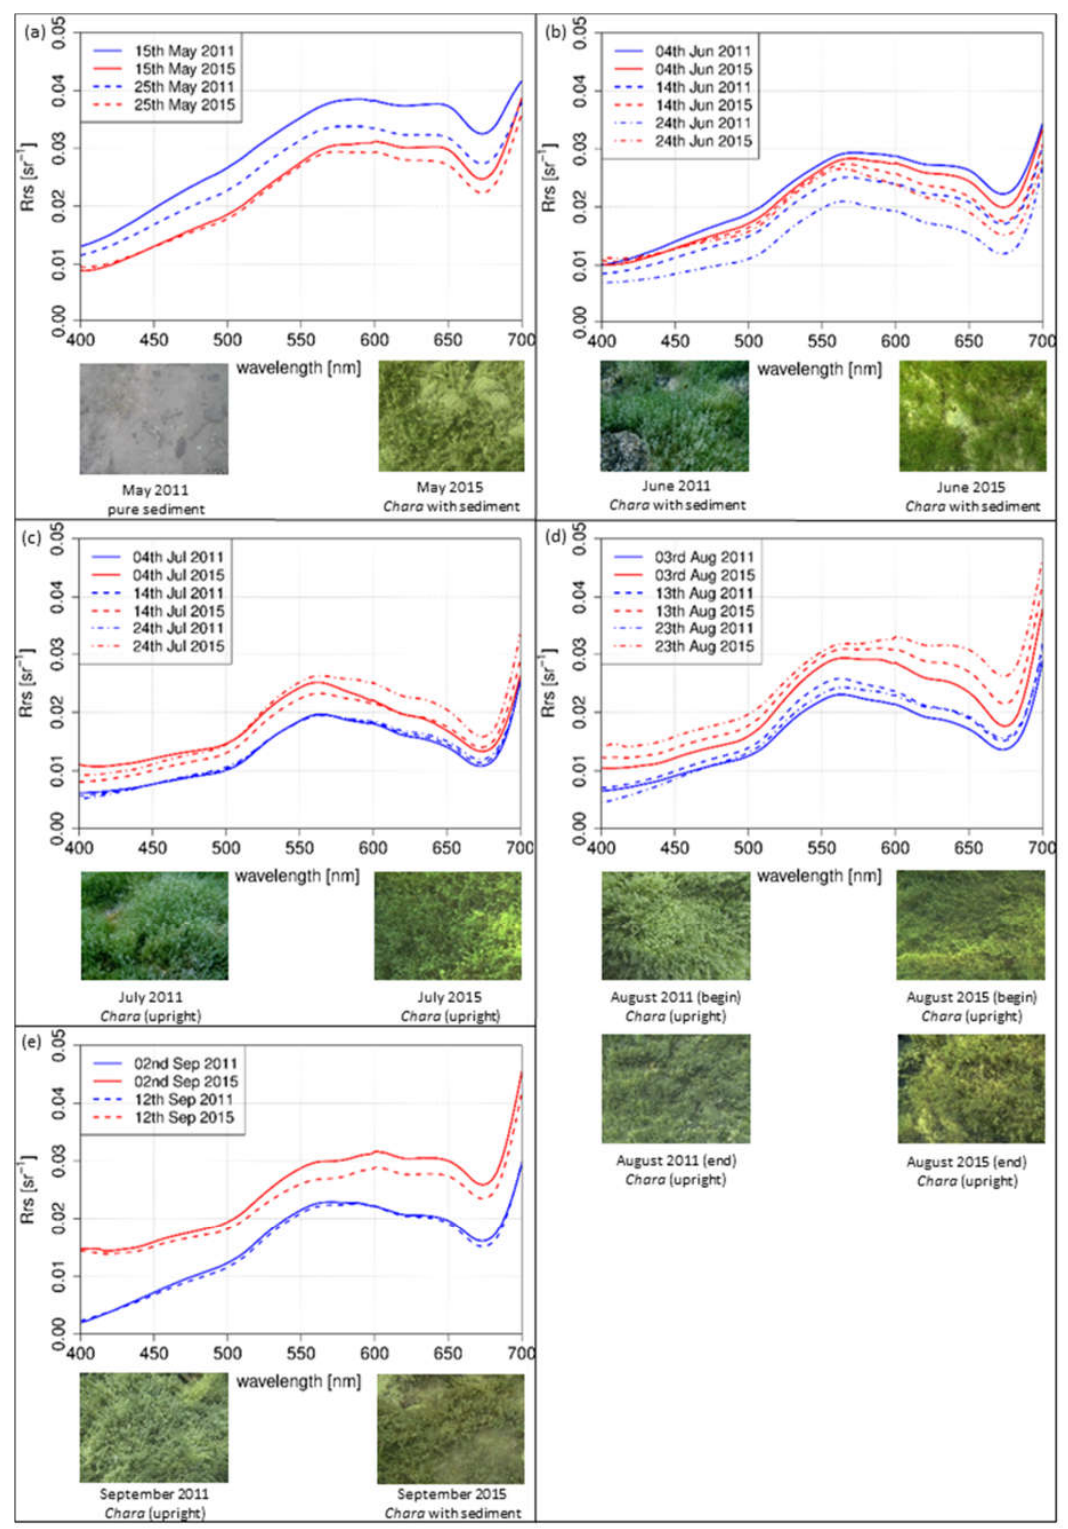
Figure 6. Simulated R rs intensities of Chara spp. modeled with a linear interpolation method of 2011 (blue) and 2015 (red). Top view photos of the investigated test sites of the sampling days: ( a ) May; ( b ) June; ( c ) July; ( d ) August; and ( e ) September.